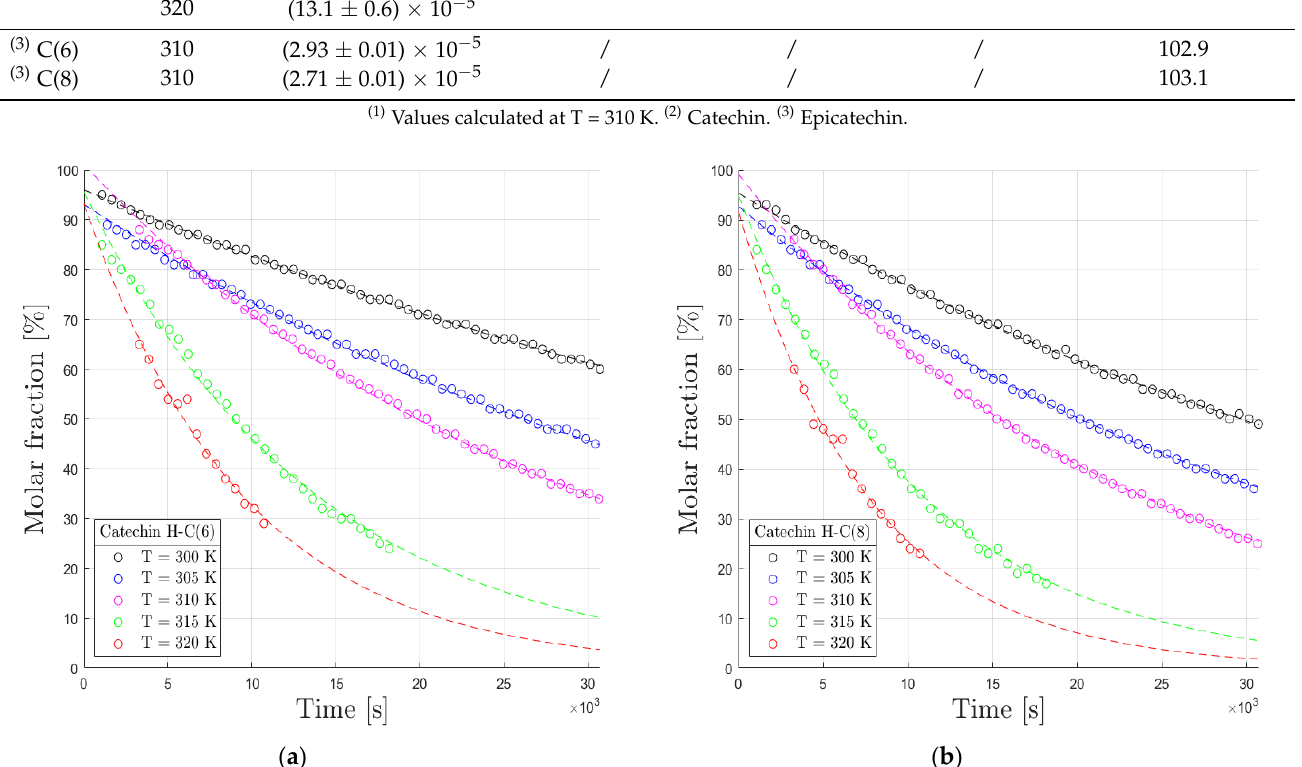
Figure 5. 1 H-NMR kinetic data, taken at five different temperatures, for H/D exchange at ( a ) C(6) and ( b ) C(8) in the catechin/D 2 O reacting system. Here, the site-specific decreasing H-C(6) and H-C(8) signals are plotted in order to obtain k’ obs ; although there is no simple relation between these observed rate constants and k i (i = 1,2,3,4,5), these data provide useful information on the site-specific deuteration kinetics.